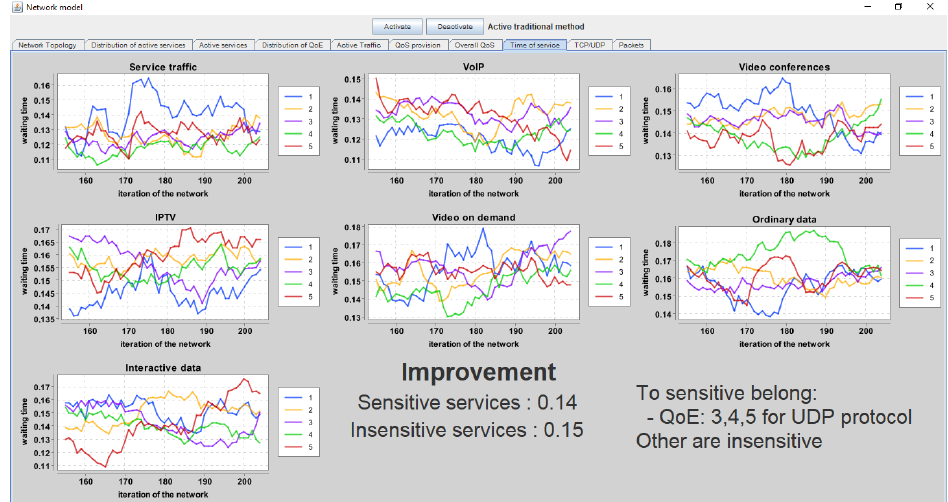
Figure 27. The average waiting time for each session with corresponding QoE score using the traditional method.